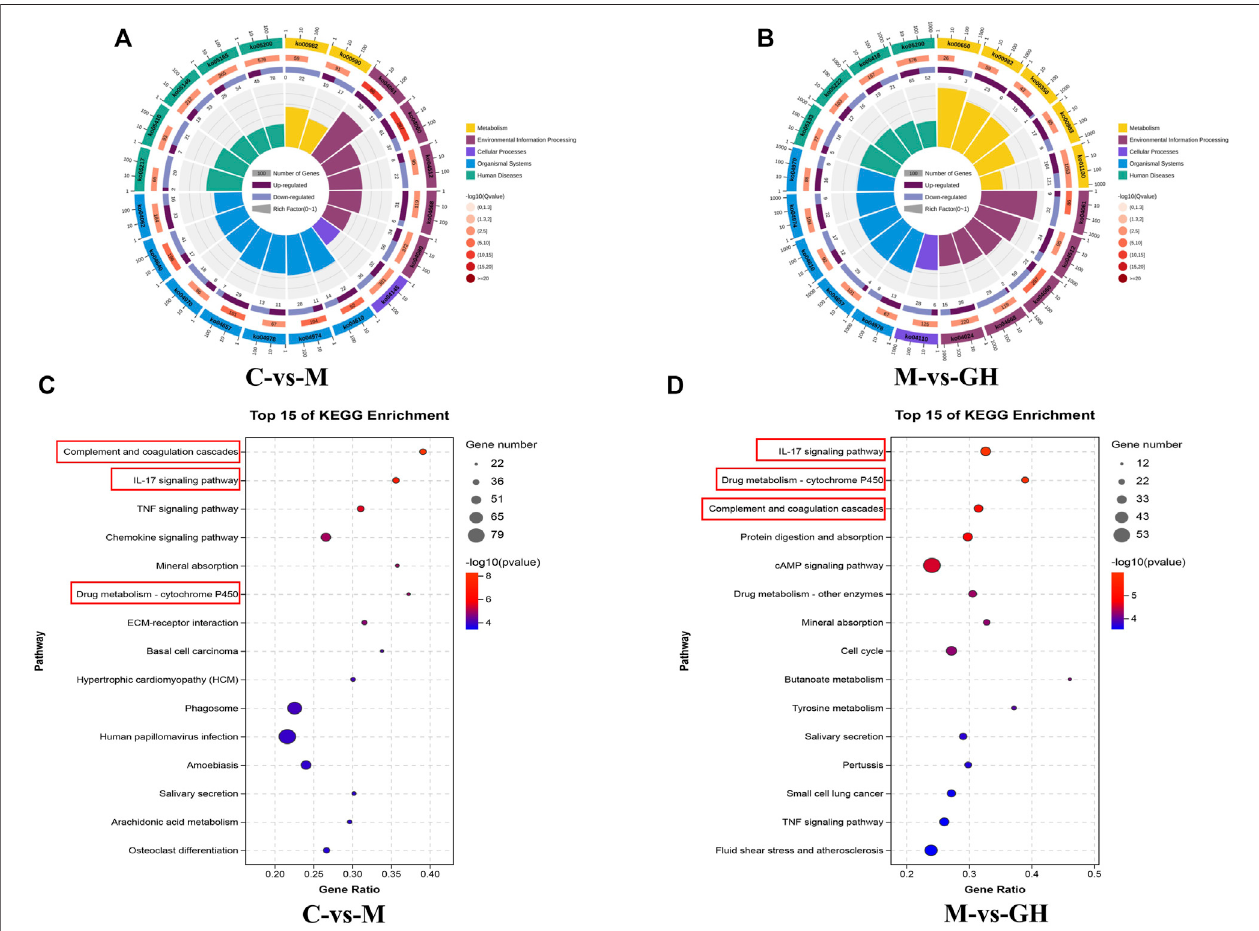
FIGURE5 | KEGG enrichmentcircle diagram and bubble diagram. (A) C-VS-M enrichmentcycle diagram. (B) M-VS-GH enrichmentcircle diagram. The fi rst circle is the pathway of the top 20 enrichment, and the coordinate ruler of the number of genes is outside the circle. Different colors represent different KEGG classi fi cations. The secondcircleisthenumber ofthepathway inthe backgroundgene andtheQvalue.Themore genes, thelongerthe bar,and thesmaller theQvalue, theredderthe color. The third circle is a bar chart of the proportion of up-regulated genes, with dark purple representing the proportion of up-regulated genes and light purple representingtheproportionofdown-regulatedgenes.Thespeci fi cvalueisshownbelow.ThefourthcircleistheRichFactorvalueofeachpathway,thebackgroundgrid line, each grid represents 0.1. (C) C-VS-M Bubble chart, (D) M-VS-GH Bubble chart. The ordinate is pathway, and the abscissa is the enrichment factor, the size indicates the quantity, the redder the color, the smaller the Q value, the higher the signi fi cance.